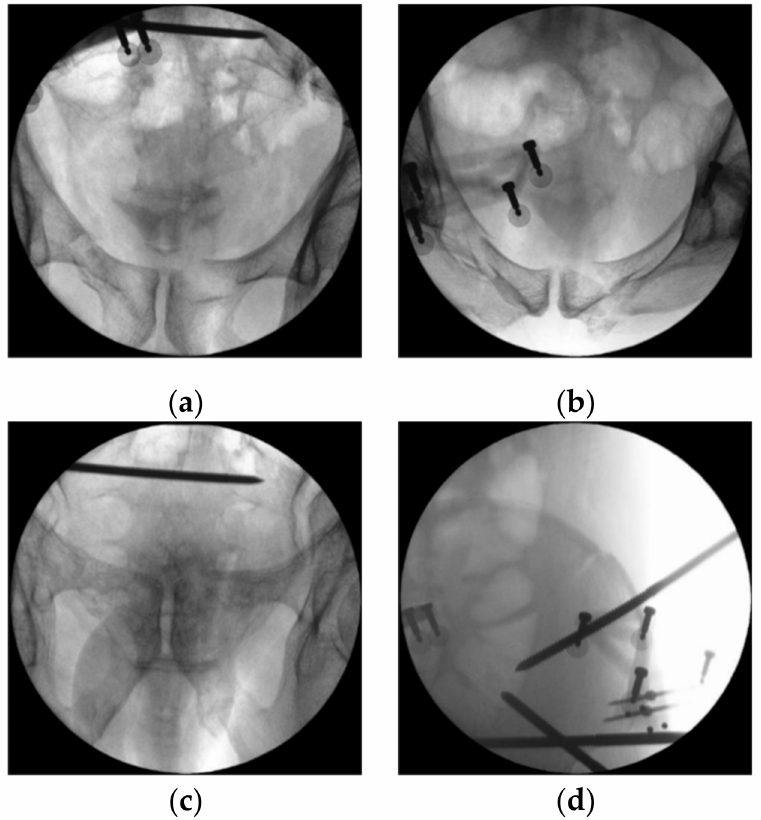
Figure 4. Intraoperative fluoroscopy after robot-assisted reduction: ( a ) AP view of anterior ring; ( b ) inlet view of anterior ring; ( c ) outlet view of anterior ring; ( d ) fracture site at the iliac